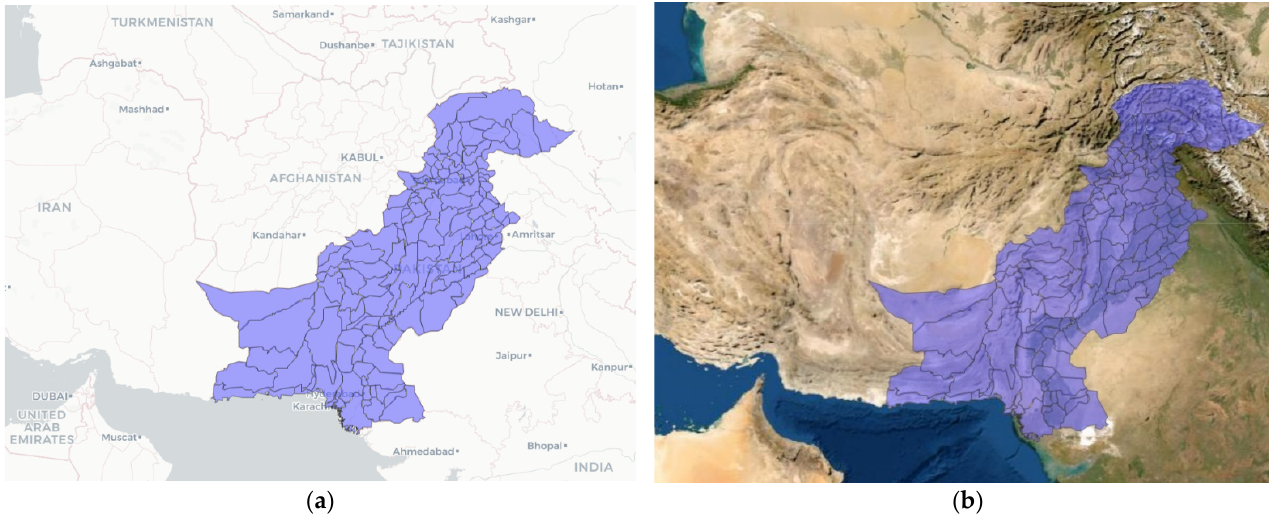
Figure 2. Regional map of Pakistan: ( a ) with administrative layer; ( b ) with topographic layer (both maps include all regions, including those that were not analysed due to a lack of data) * is location of capital city on the map.